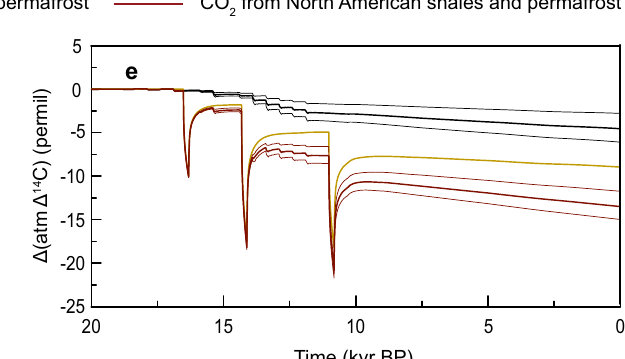
dashedlinesindicate scenariosthatthemodern F oxidation =1tCkm − 2 yr − 1 isvalid for shalesofasubstrateageof5and15kyrs,respectively.Redlinesmarktheestimated past OC petro oxidation fl uxes derived from the data of core ARA04C/37; c carbon release from OC petro oxidation, short-term peaks are attributed to the J carbon cal- culated in steps of 100 years for every 500-year exposed areas; simulated anomalies in d atmospheric CO 2 levels and in e atmospheric Δ 14 C using the global carbon cycle model BICYCLE 30